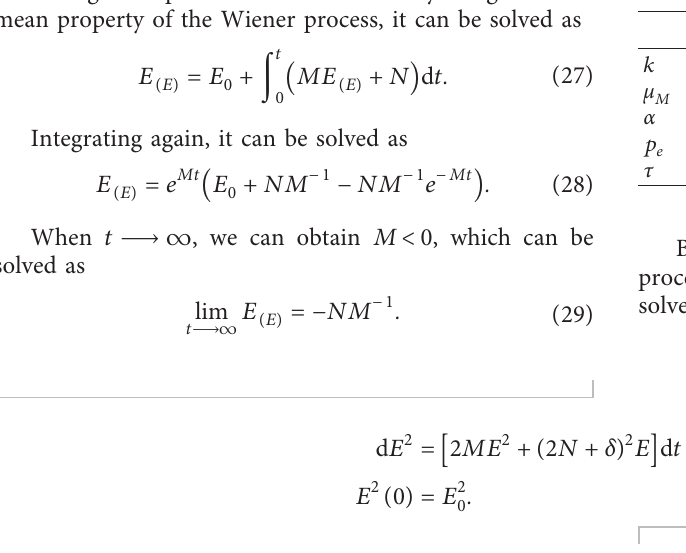
Table 2: Parameter sensitivity